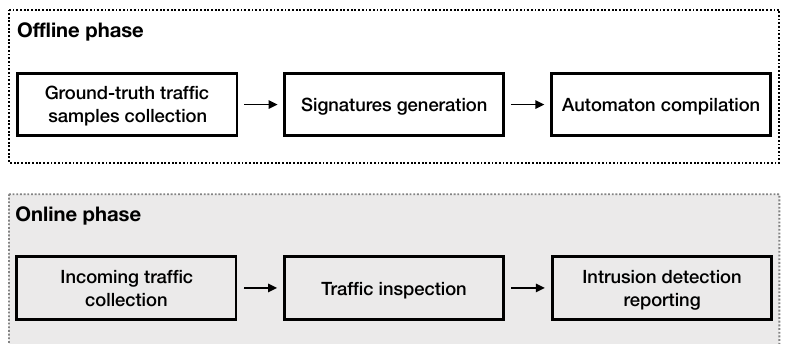
Figure 1. A high-level design overview of this work. In the offline phase, we (i) process the ground- truth dataset retrieved from [13], (ii) we generate signatures, and (iii) we build the automaton. In the online phase, we process the input traffic using our intrusion detection engine that reports any suspicious activity identified by our